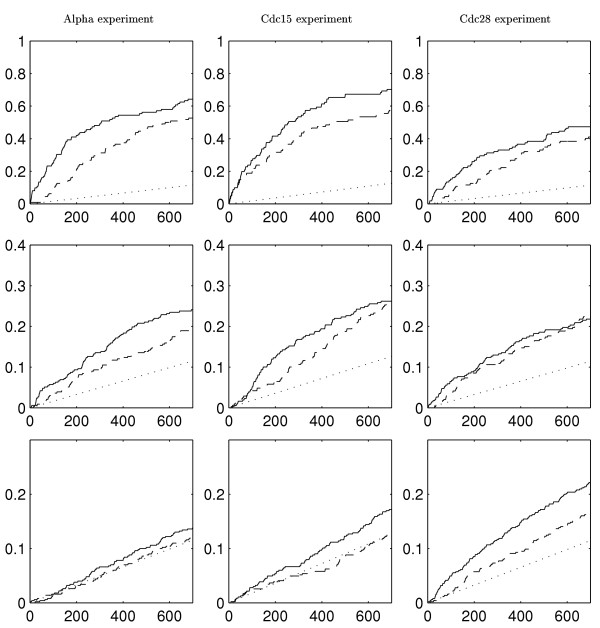
Benchmark results. The fraction of the benchmark set that is identified (y-axis) as the function of the highest ranked genes (x-axis). The solid (resp. dashed) line corresponds the robust detection having fixed (resp. unknown) frequency. The dotted line shows the performance of the random gene selection. The columns from left to right correspond to the Alpha, the Cdcl5 and the Cdc28 experiment by [6]. The rows, from top to bottom, correspond to the three different benchmark gene sets B1, B2 and B3. for more details about the benchmark gene sets, see [24].